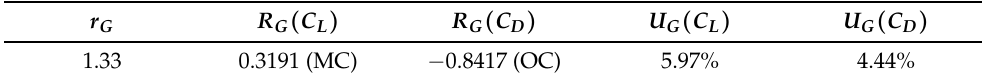
Table 3. Grid uncertainty of the CFD